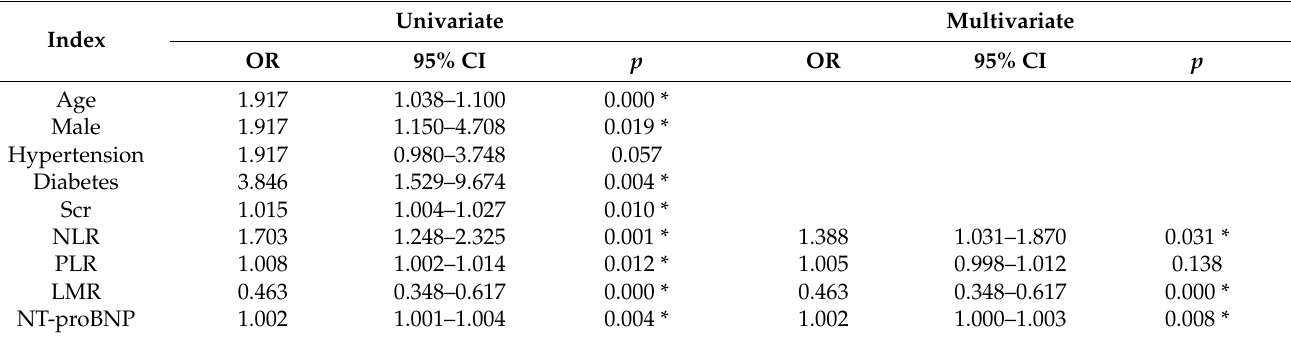
Table 3. Logistic regression analysis for